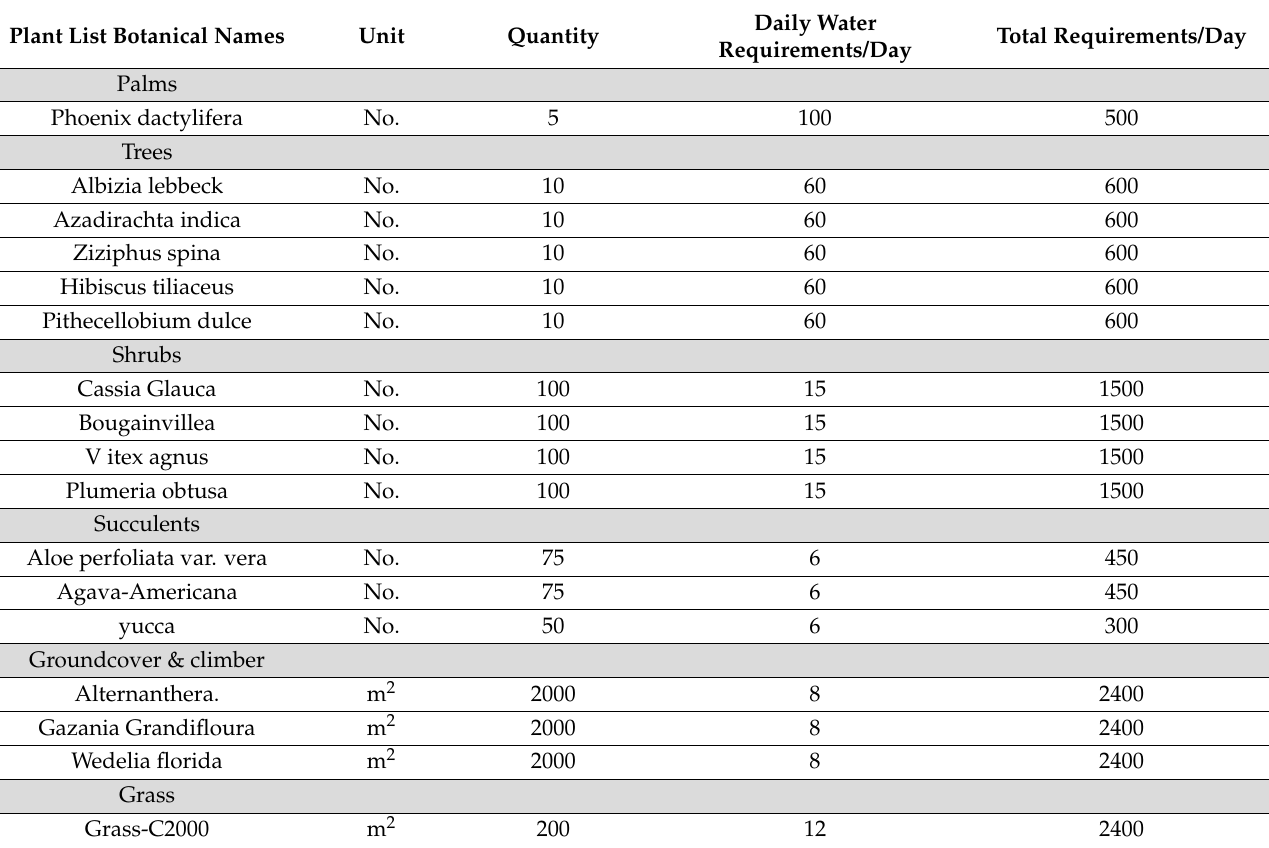
Table A9. Study proposal for applying Xeriscaping concept in area 30 m × 30